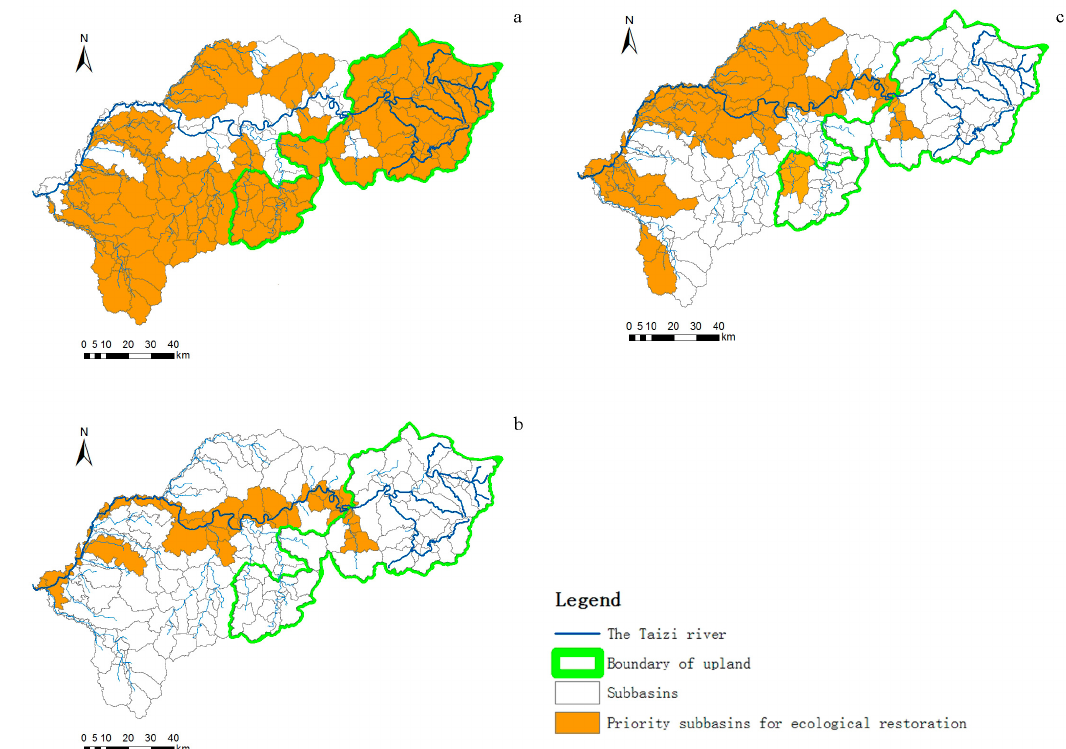
Figure 9. Priority zones (sub-basins) for ecological restoration in the dry season ( a ), the flood season ( b ), and the average water season ( c ).